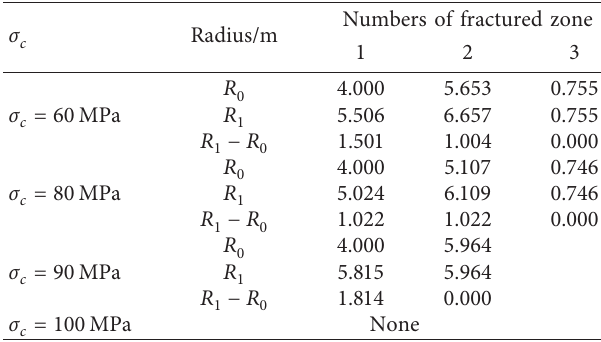
Table 3: The width and quantity of fractured zone when excavation time is 1000s [35].